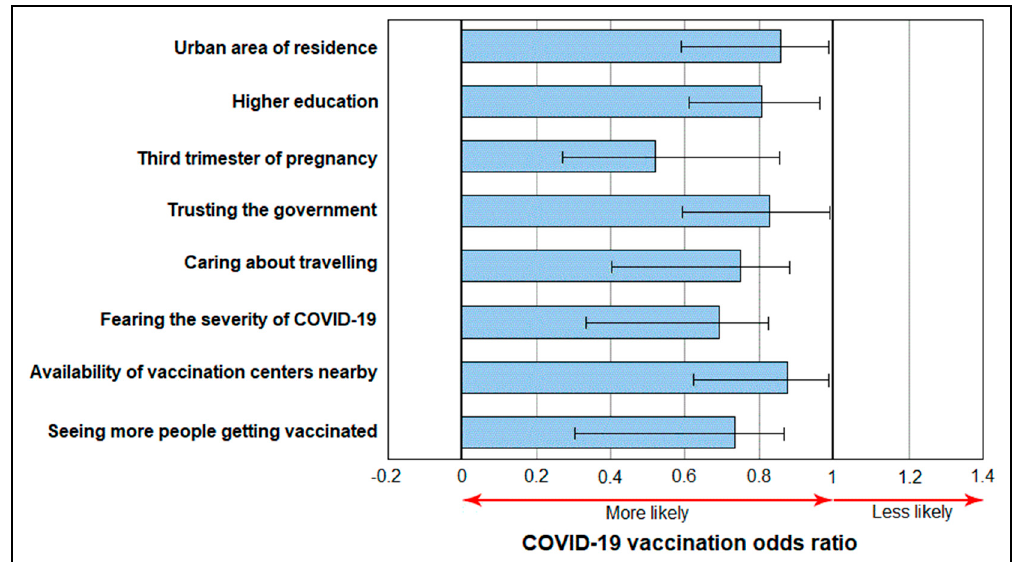
Figure 3. Determinant factors of the likelihood of COVID-19 vaccination.